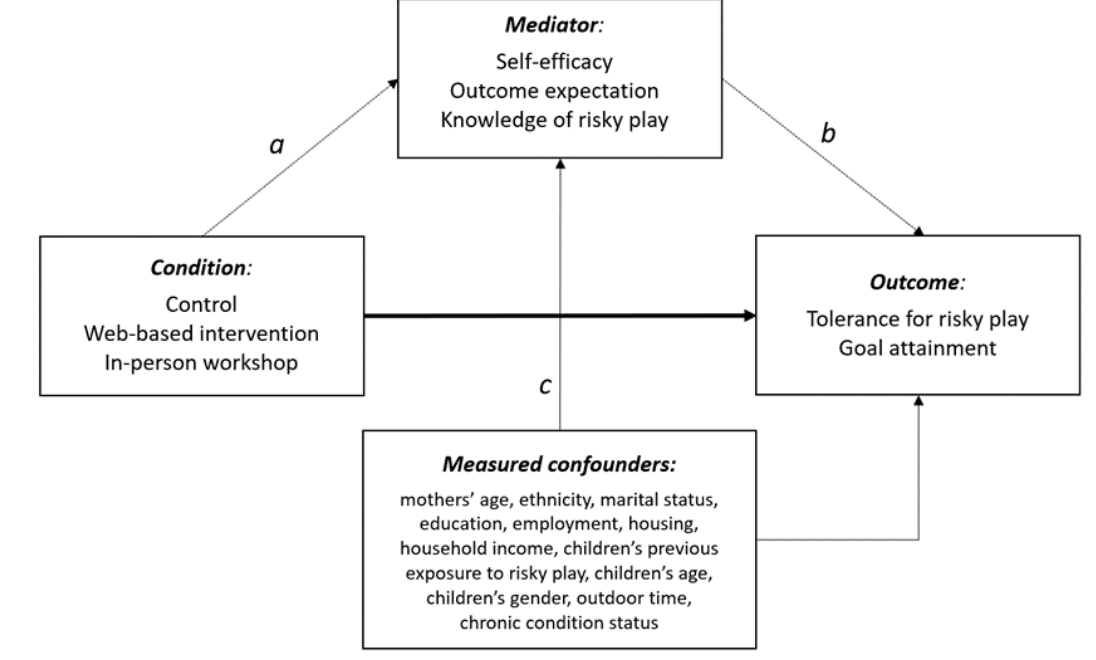
Figure 3. Mediation